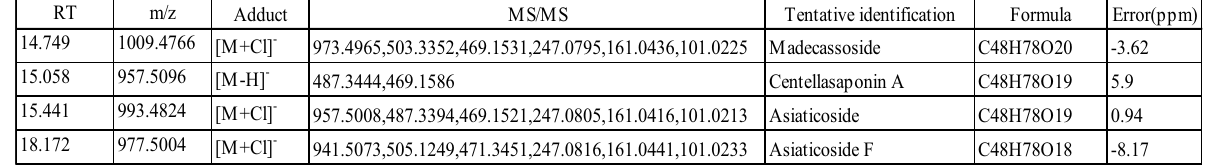
Figure 4. Total ion chromatogram of Centell-S at concentration 1 mg/mL operated in negative mode (top), the proposed structure of compounds found in Centell-S (middle), and MS/MS data of their tentative identification